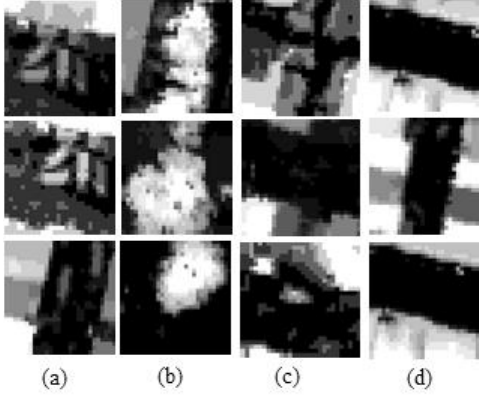
Figure 4. Sample of training data, (a) car, (b) tree, (c) debris, and (d) intact road